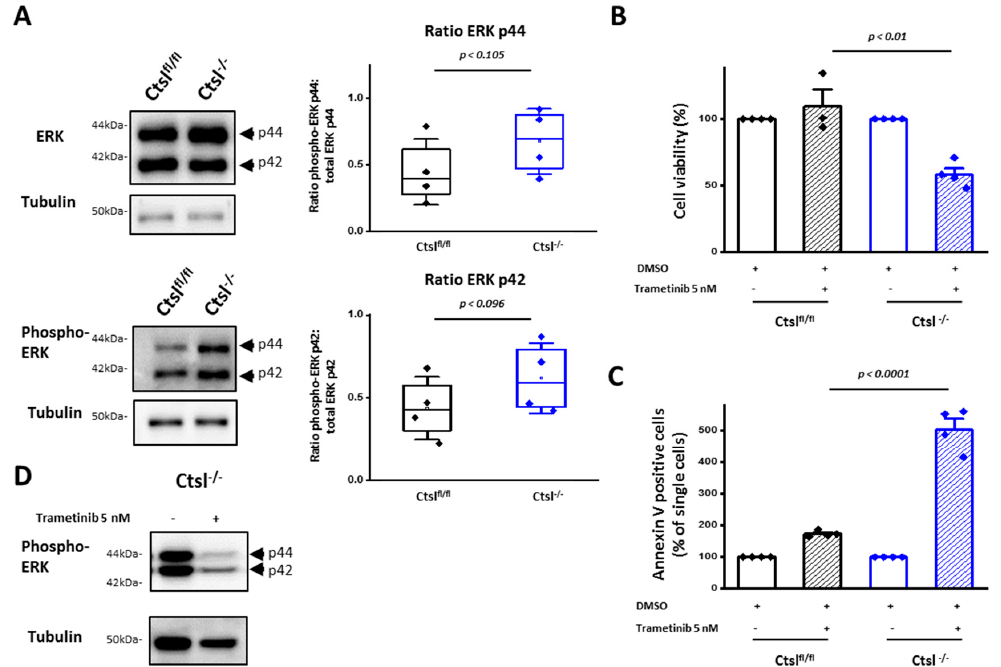
Figure 8. Ctsl − / − breast cancer cells depend on enhanced phosphorylation of ERK 1 and 2 for survival. ( A ) Representative Western blot images of ERK 1 (p44) and ERK 2 (p42) and respective phospho-ERK 1 and 2, and quantification of the phosphorylation status ( n = 4; two sample t -test); mean ± S.E.M. Phosphorylation was detected at the residues threonine 202 and tyrosine 204 of ERK 1, and the corresponding threonine 185 and tyrosine 187 of ERK 2. Alpha-tubulin was used for normalization. ( B ) Cell viability analyzed upon Trametinib treatment by MTT ( n = 4, p < 0.01, two sample t -test); mean ± S.E.M. ( C ) Apoptotic cell death indicated by Annexin V binding upon Trametinib treatment ( n = 4, p < 0.0001, two sample t -test); mean ± S.E.M. ( D ) Representative Western blot image corroborating the inhibition of ERK phosphorylation upon Trametinib treatment.